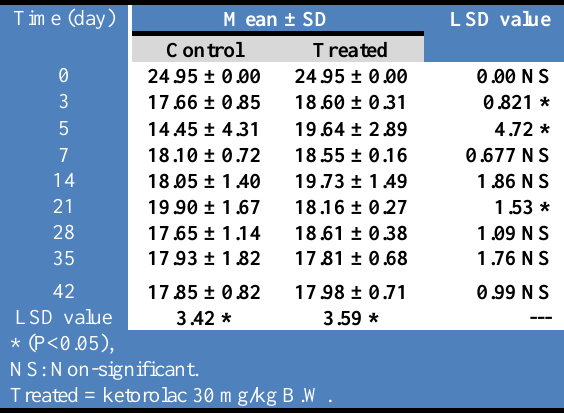
Table, 5: Shows MCHC concentration (g/dl) in control and ketorolac treated rabbits.